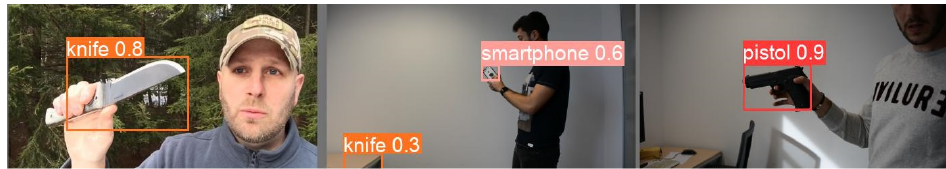
Figure 4. Sample of objects detected by YOLOv5n with their confidence.